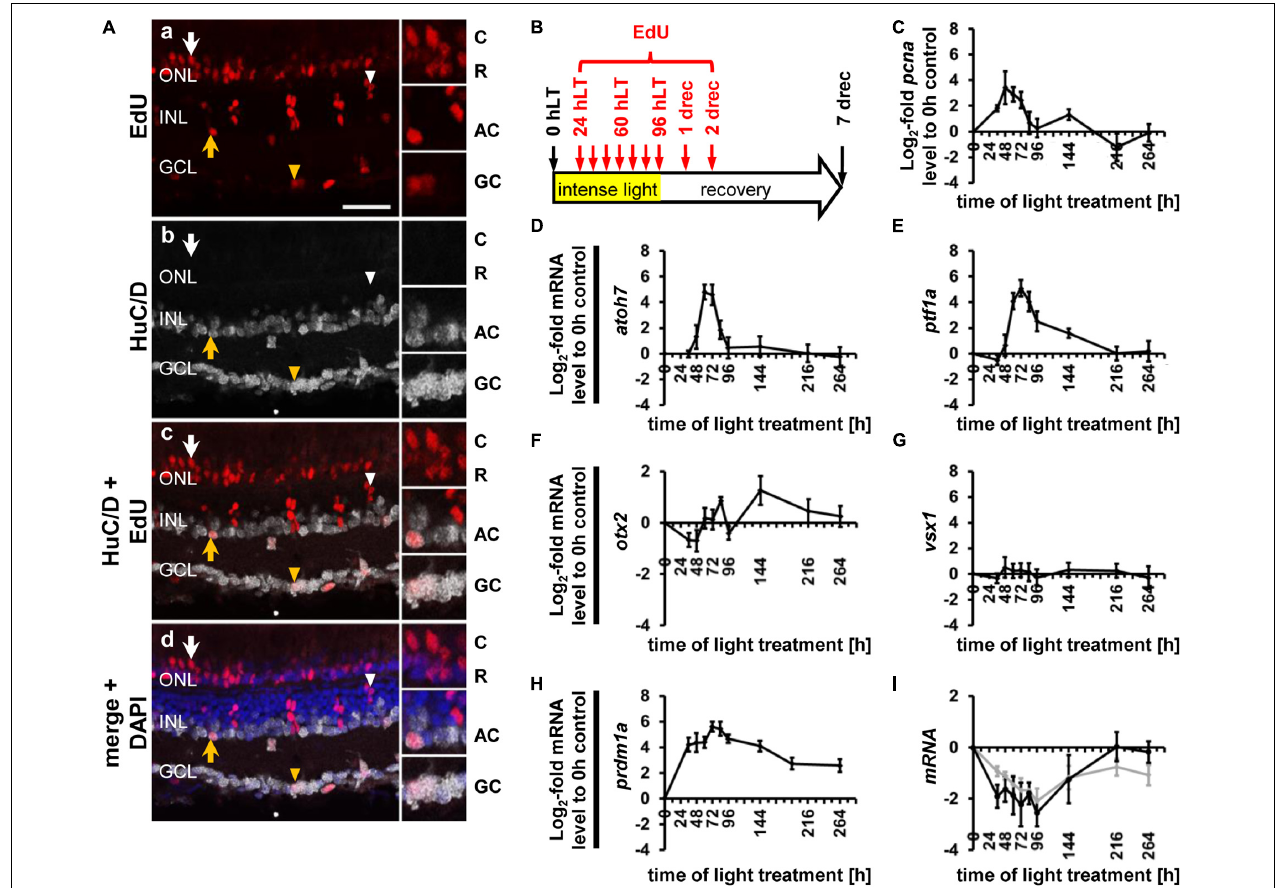
FIGURE 1 | Generation of all neuronal cell types and expression of cell type specific developmental competence factors in the light-damaged retina. (Aa–d) Single z-plane confocal images of retinal sections from light-damaged EdU-injected albino zebrafish (Aa,c,d) at 7 days of recovery (drec) immunolabeled for the amacrine/ganglion cell marker, HuC/D (Ab–d) , and counterstained with the nuclear dye, DAPI (Ad) . Yellow arrowhead, GCL EdU-positive ganglion or amacrine cell; yellow arrow, INL EdU-positive amacrine cell; white arrowhead, EdU-positive and HuC/D-negative cell in the apical INL, the region where bipolar cells reside; white arrow, EdU-positive cell in the cone nuclear layer. Insets represent the EdU-positive cells in panels (Aa–d) (arrows; yellow arrowhead) displayed at higher magnification. Scale bar, 20 µ m in panel (Aa) . (B) Schematic of the experimental paradigm: albino zebrafish were exposed to constant intense light for 96 h and subsequently recovered under normal light conditions until 7 drec. Fish were intraperitoneally injected with EdU at 24, 36, 48, 60, 72, 84, 96 hLT and at 1 and 2 drec (red arrows). AC, amacrine cell; C, cone photoreceptor cell; GC, ganglion cell; GCL, ganglion cell layer; hLT, hours of light treatment; INL, inner nuclear layer; ONL, outer nuclear layer; R, rod photoreceptor cell. (C–I) Line plots displaying mRNA expression levels as log 2 -fold changes relative to 0 h controls for proliferation marker, pcna (C) and genes required for the developmental specification of retinal neurons (D–I) during light damage-induced retinal regeneration (0, 36, 48, 60, 72, 84, 96 hLT, 2, 5, 7 drec): (D) atoh7 (ganglion cells); (E) ptf1a (amacrine/horizontal cells); (F) otx2 (bipolar and photoreceptor cells); (G) vsx1 (bipolar cell); (H) prdm1a (photoreceptor cell); (I) nrl (gray line, rod photoreceptor cell specification) and mature rod photoreceptor cell gene, rhodopsin (black